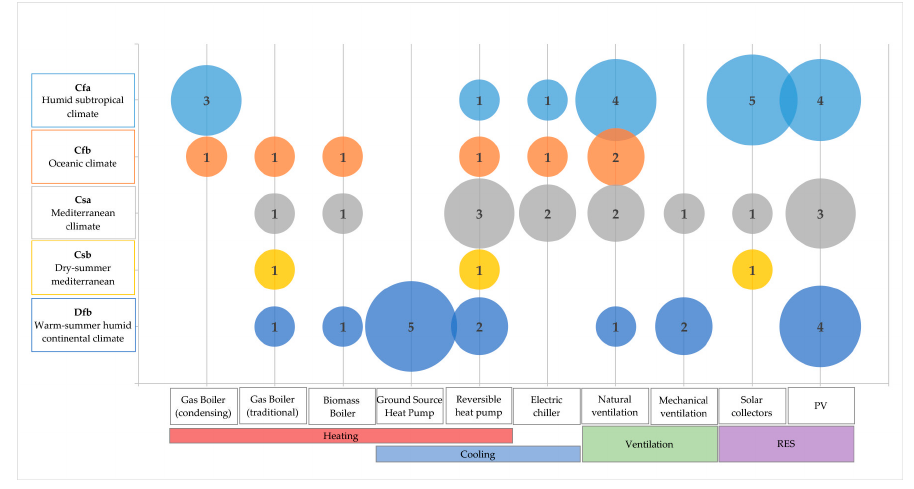
Figure 20. Optimal EEMs for energy systems—single-family residential buildings.